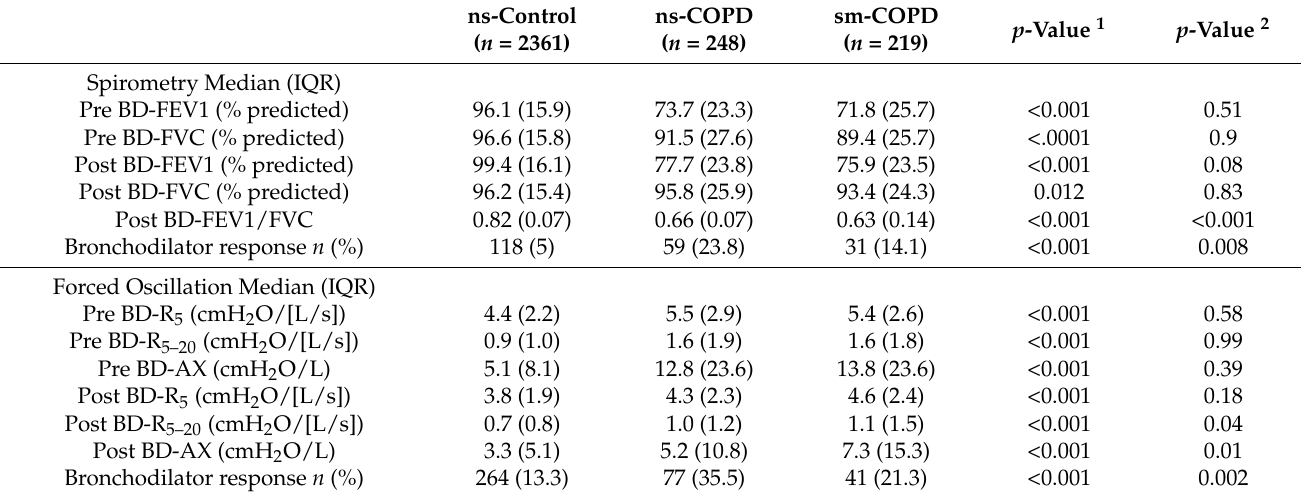
Table 2. Spirometry and oscillometry results